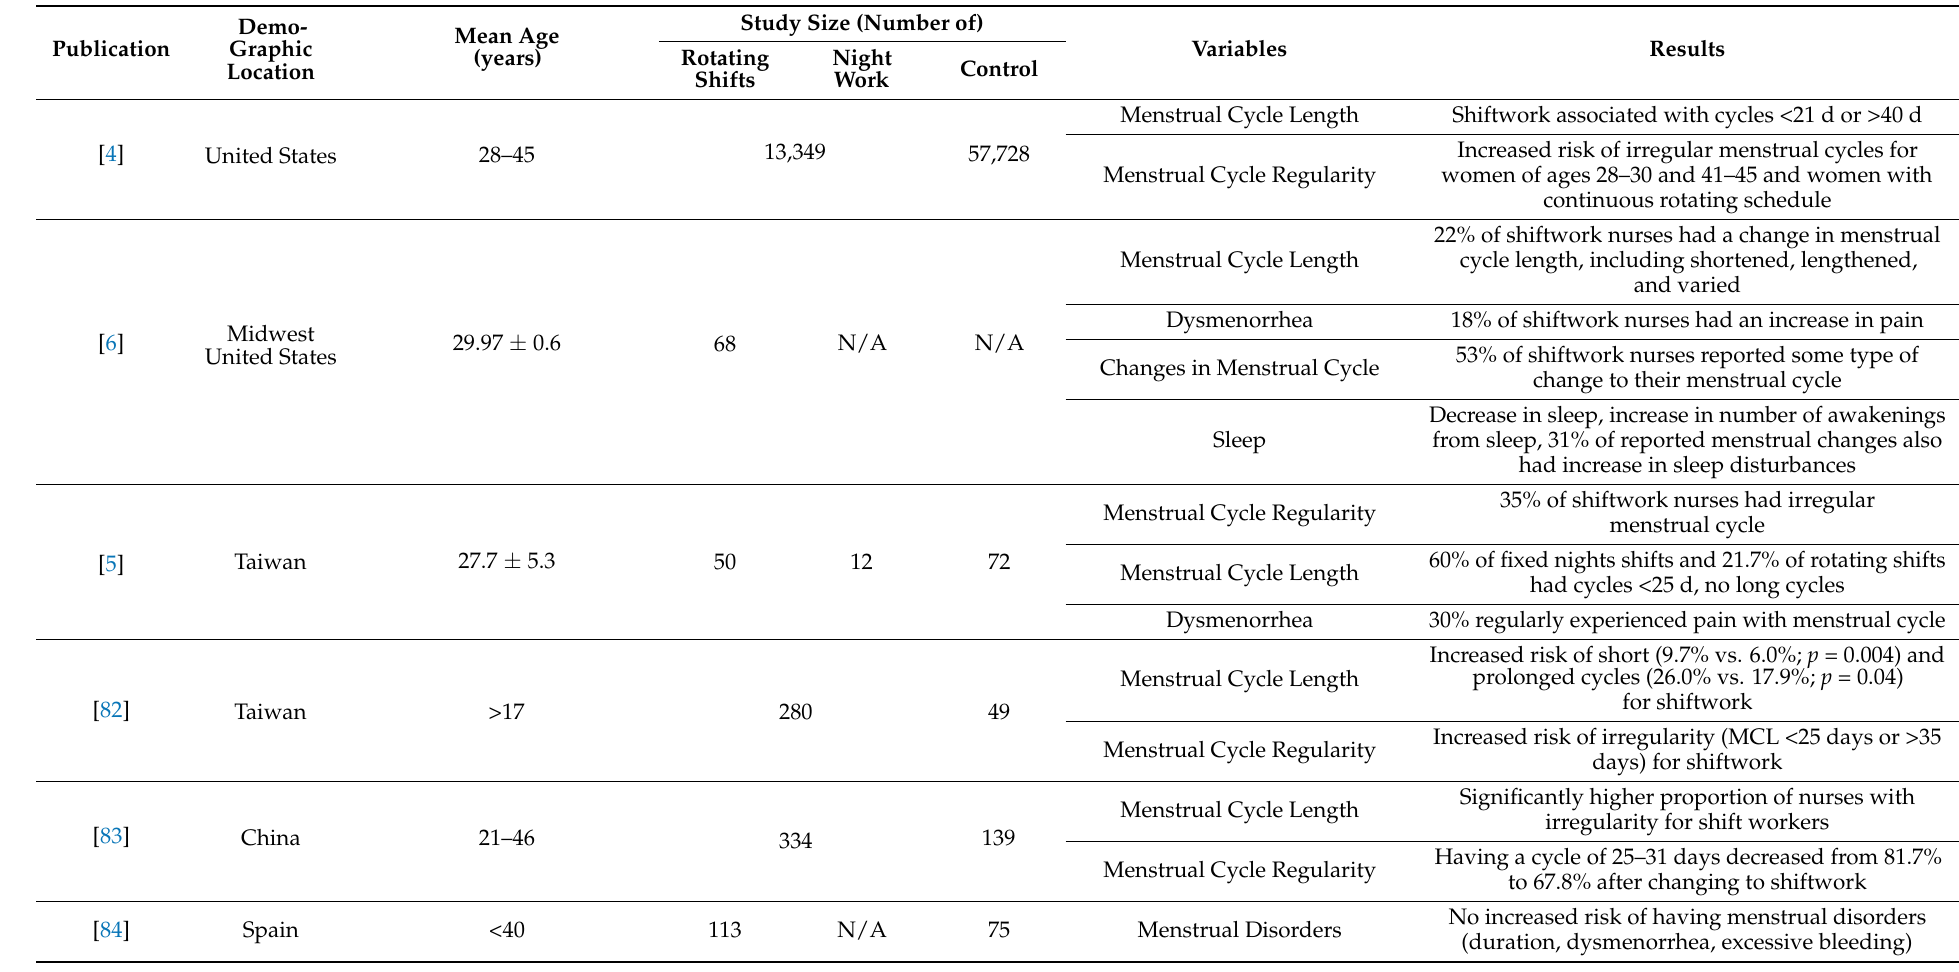
Table 1. Summary of outcomes in human studies focused on female shift workers and reproduction included in this